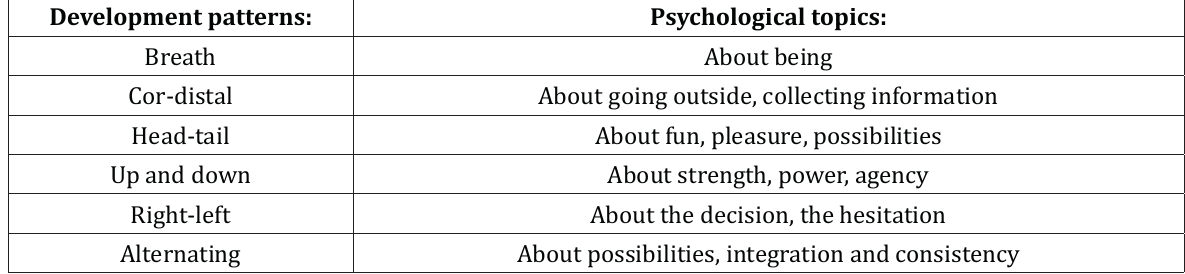
Table 5. Development patterns (source: own elaboration based on information from LBMS and [50] lectures) Development